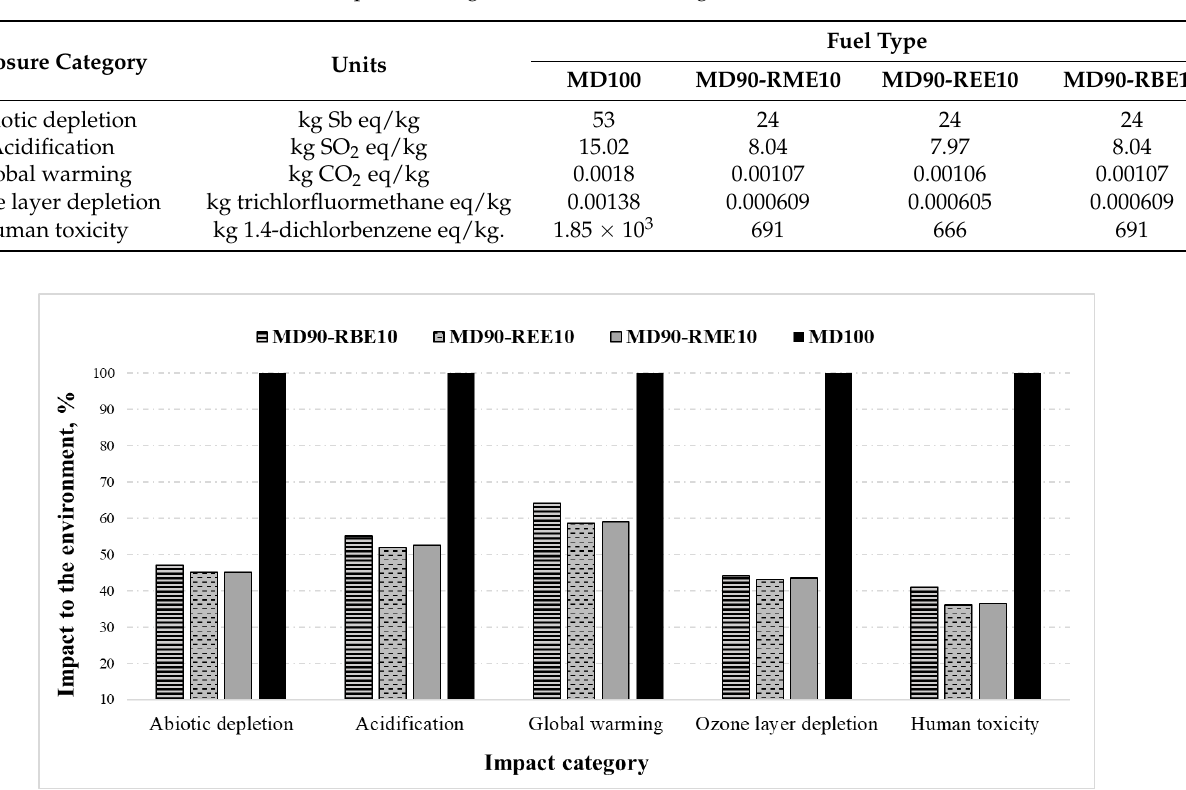
Figure 3. Comparison of the environmental impact of fuel mixtures with regard to the alcohol used in production, assessed using the CML-2 baseline 2000 method (values of mineral diesel are equated to 100%).